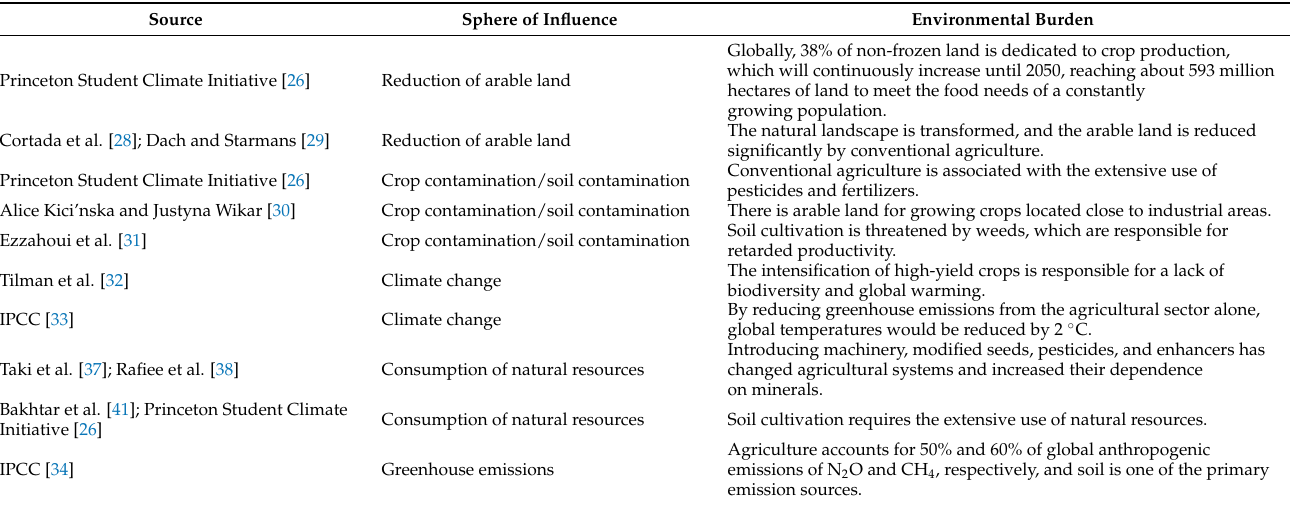
Table 1. Areas of the environmental burden resulting from conventional agriculture.